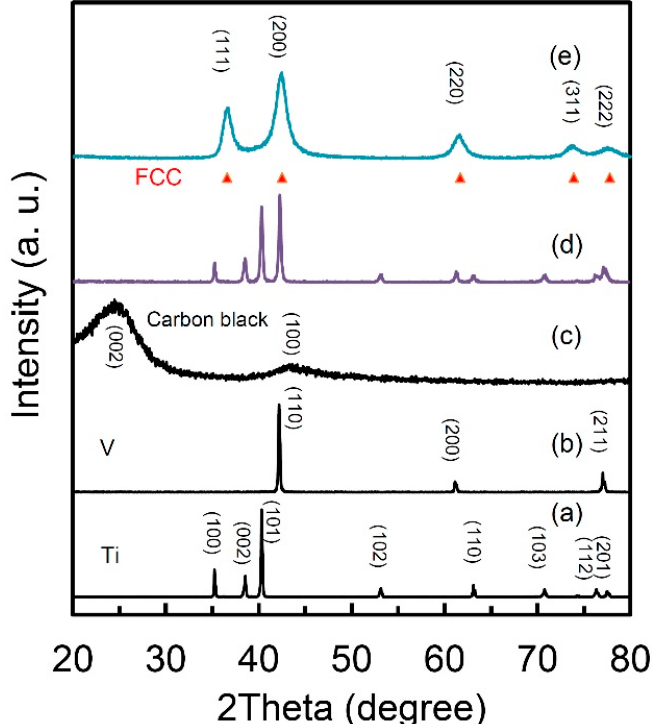
Figure 1. X-ray diffraction pattern of ( a ) Ti; ( b ) V; ( c ) carbon black; ( d ) mixture of Ti 50 V 50 +10 wt.% carbon black and ( e ) Ti 50 V 50 -10% C alloy with face-centered cubic (FCC) structure after 10 h mechanical alloying process.